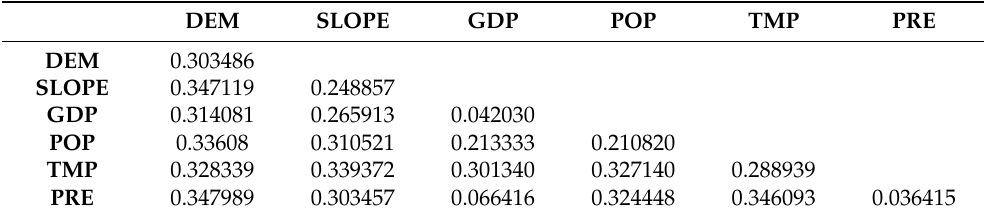
Table A8. The force (q-value) among any two influencing factors on Patch density (PD) interactively in 2020.